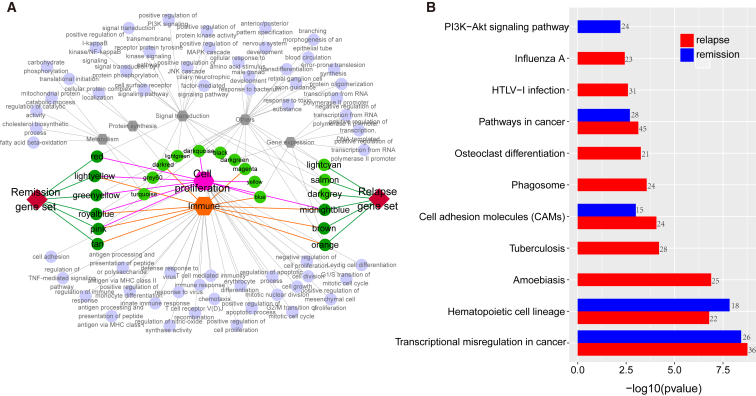
The Function Analysis of Modules(A) The GO enrichment of 22 WGCNA modules (p value < 0.05). Purple, GO terms; green and dark green, modules; gray, function type. (B) KEGG pathways enriched by the specific gene sets (relapse/remission gene sets) (p value < 0.01).